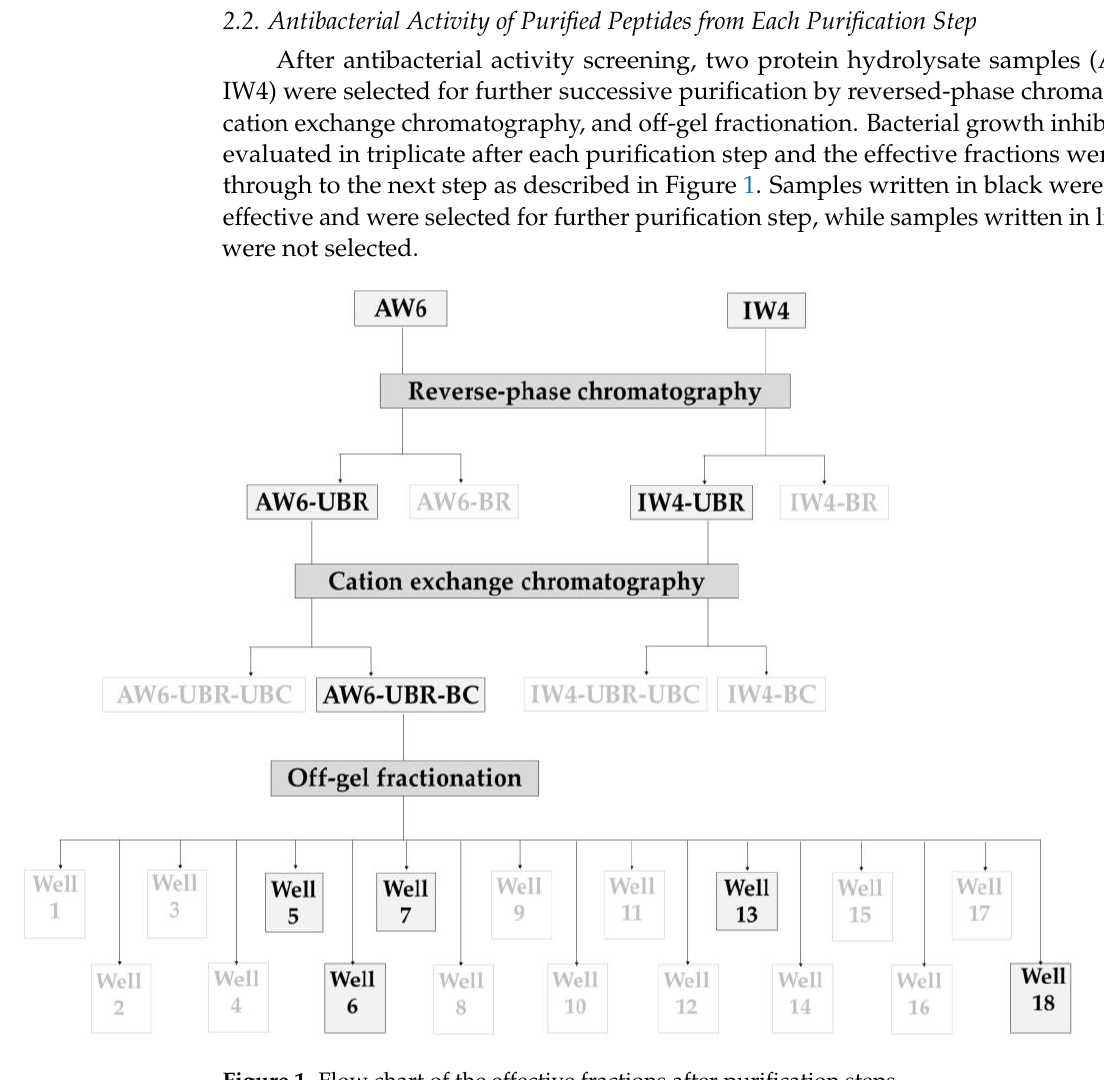
Figure 1. Flow chart of the effective fractions after purification steps. For both AW6 and IW4, the unbound fraction from reversed-phase chromatography (UBR) exhibited higher inhibitory potential than the bound fraction (BR), i.e., hydrophilic fractions gave higher activity than hydrophobic fractions. After cation exchange chromatog- raphy through a HiTrap SP Sepharose FF 1 mL (Cytiva) column, peptides with high activity were found to bind to the column and named AW6 UBR-BC. Accordingly, the AW6 UBR-BC fraction was chosen to be purified by off-gel fractionation and five bioactive fractions were selected for the analysis of peptide sequences using LC-MS/MS and Mascot